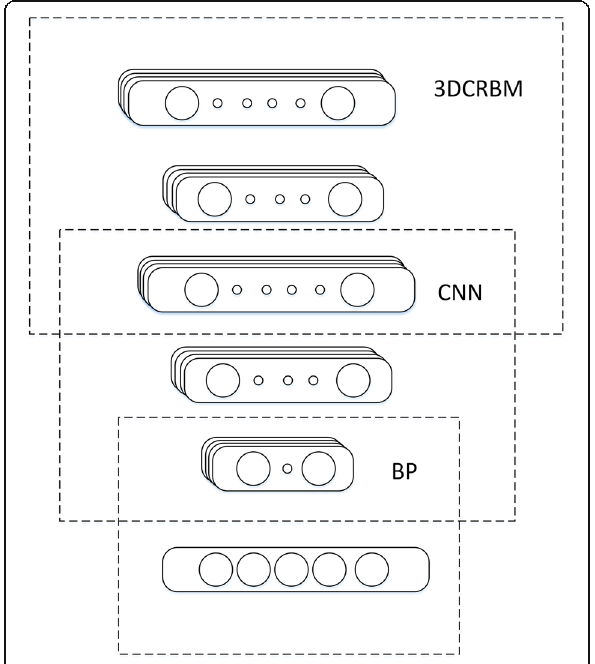
approximation, the S layer of the 3DCRBM